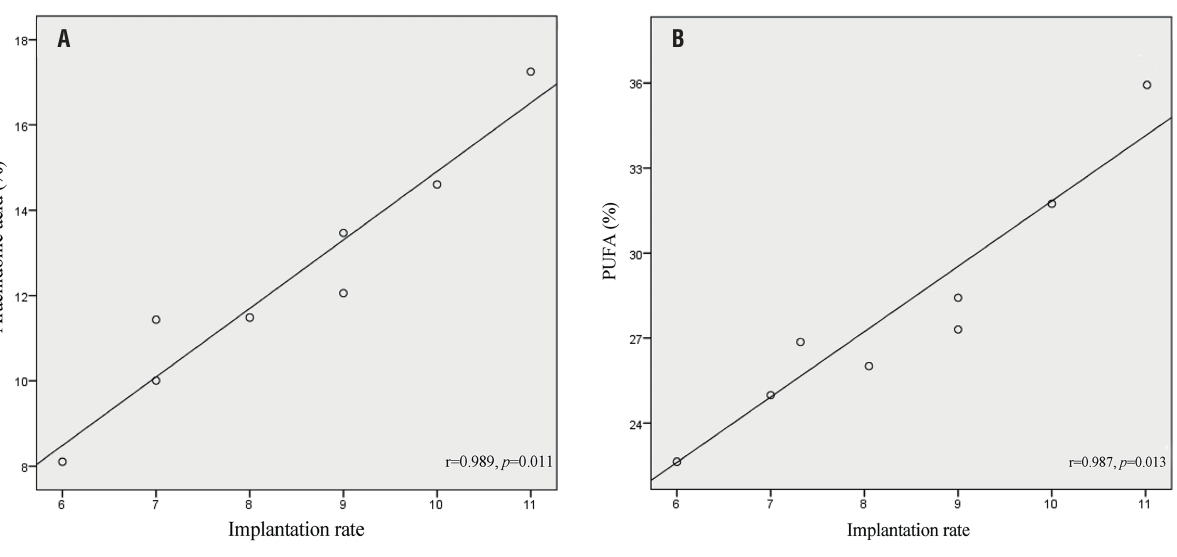
Figure 2 - Correlation between implantation rate with a) arachidonic acid (ARA) and b) polyunsaturated fatty acid (PUFA) levels on the fifth day of pregnancy in the control